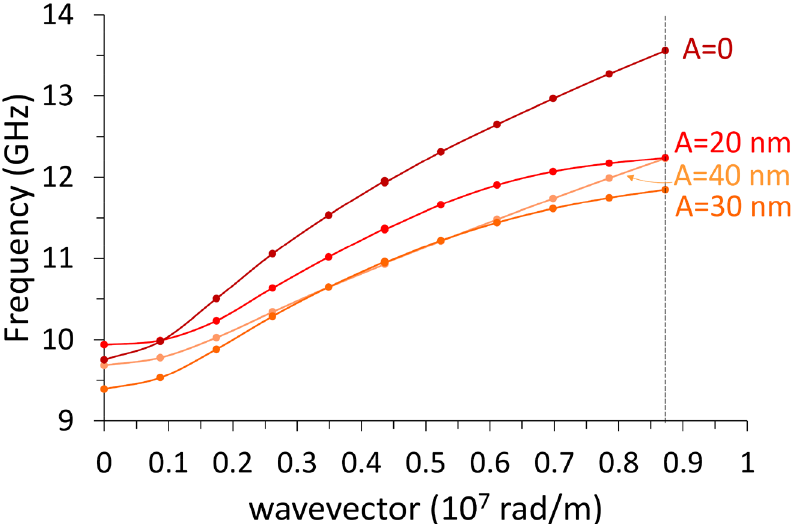
Figure 9. Dispersion curves for the DE mode ( k ⊥ M ) in the configuration M (cid:31) x : these waves do not follow the film periodicity, though their frequency varies with the system geometry. Lines are guides for the eyes. Following the same red shades of Fig. 5, the darkest corresponds to the planar film (A = 0), the lighter ones to the 4, 6 and 8-stripe systems, in order. The 12-stripe (A = 60 nm) system is absent since it doesn’t show any bulk solution, but only an edge one, as shown in Fig. 7e.